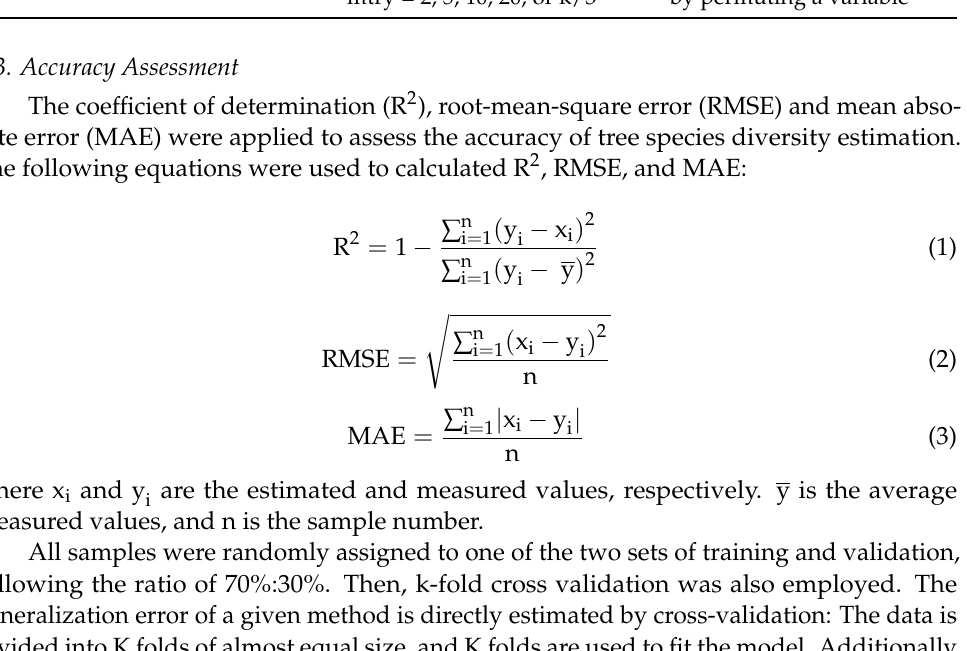
Table 4. Description of the regression models used in this study, including the parameters considered and the criteria used to rank the feature importance. Model Abbr. Parameters Feature Rank Criteria Lasso regression LR — Absolute value of coefficients K-Nearest K values = 3, 5, 7, 9, 11 Minimum error Neighbors